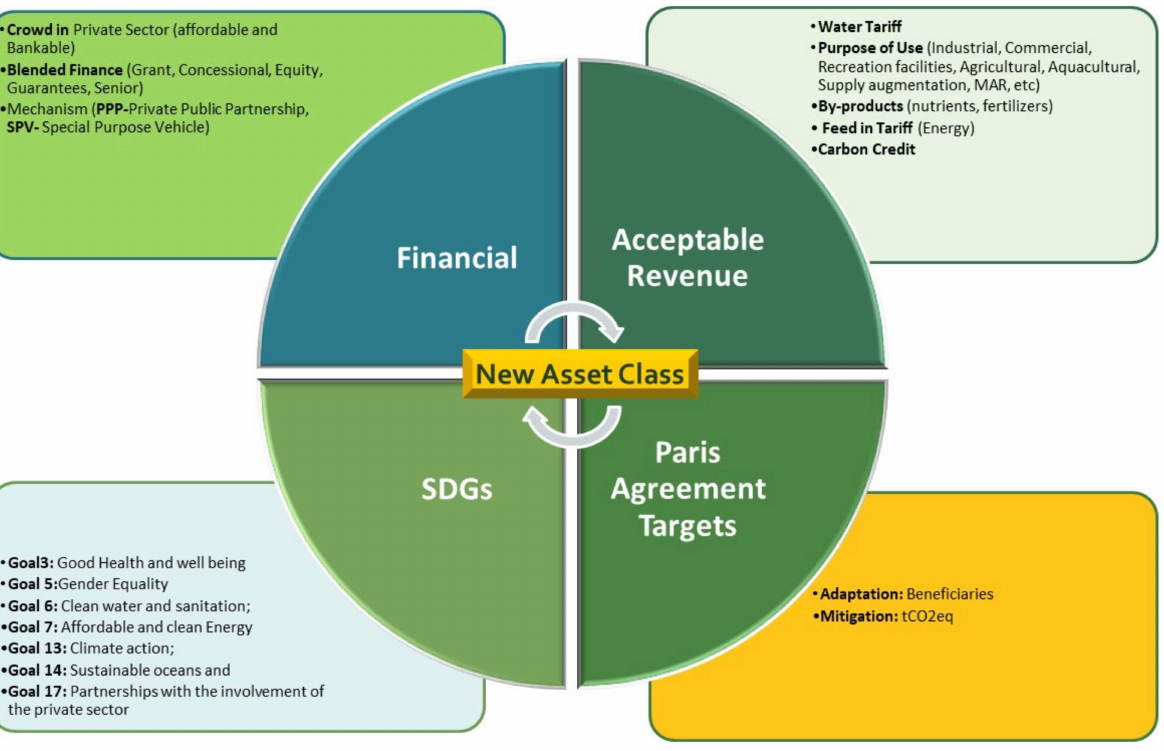
Figure 2. Key Characteristics of the New Asset